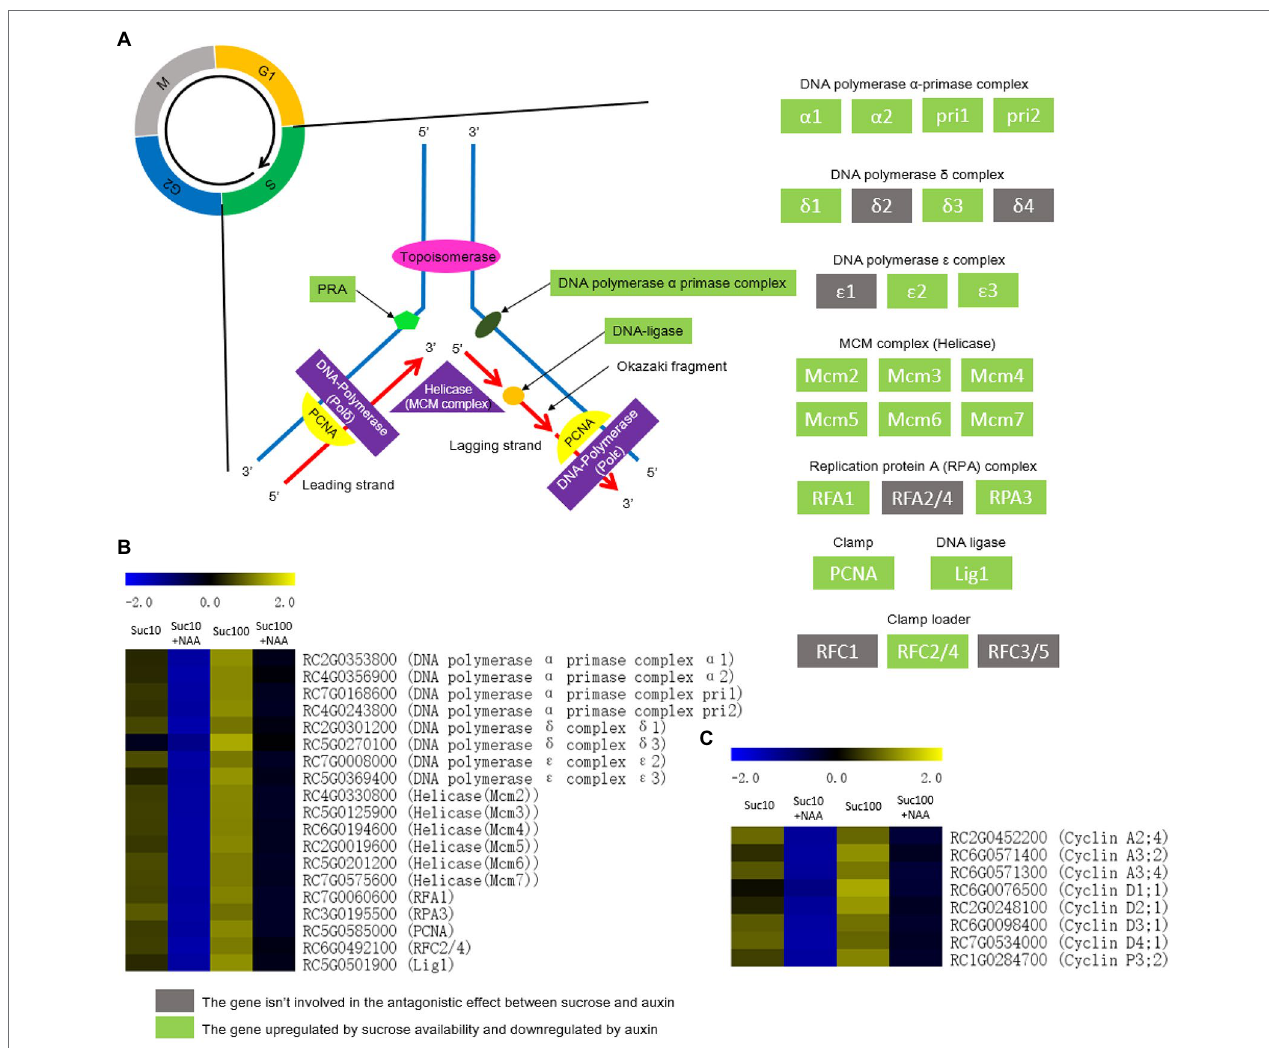
FIGURE 7 | DNA replication and cell division are antagonistically regulated by auxin and sugar in axillary buds. Suc10, 10 mM sucrose; Suc10 + NAA, 10 mM sucrose +1 μ M NAA; Suc100, 100 mM sucrose; and Suc100 + NAA, 100 mM sucrose +1 μ M NAA. (A) Sucrose and auxin antagonistically regulate the transcription level of many key factors of DNA replication; (B) several genes that encode the key factors of DNA replication are regulated by the antagonistic effect of sucrose and auxin; and (C) several genes related to the cell cycle are regulated by the antagonistic effect of sucrose and auxin. Dark green labels, enzymes-encoding genes repressed by auxin but stimulated by sucrose. Gray labels, enzymes-encoding genes repressed by sucrose but stimulated by auxin. Heatmap color (blue to yellow), gene transcription level (low to high,